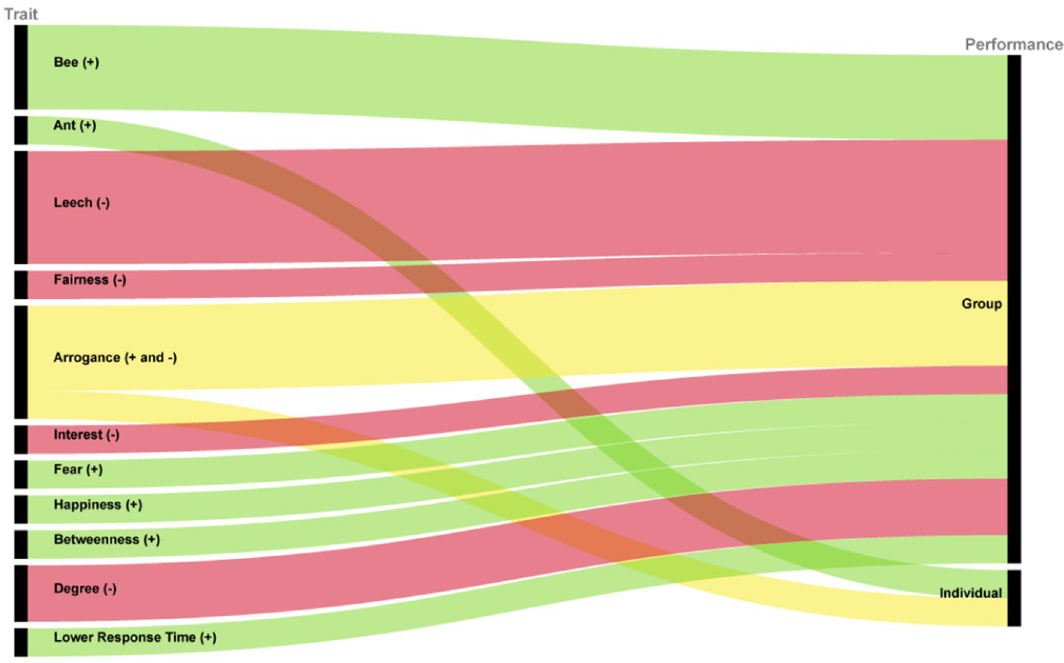
Figure 2. Variables impacting group and individual